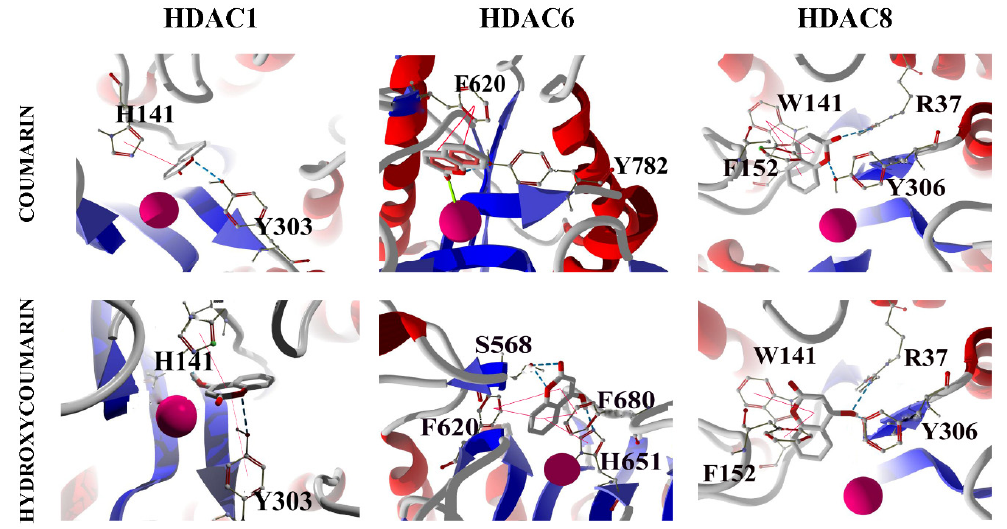
Figure 9. Potential interactions between the coumarin and 4-hydroxycoumarin and the residue in the active site of HDAC1, HDAC6 and HDAC8. The stacking interactions are show as a red line, hydrogen bond is blue dotted line and the coordination bond with Zinc is the green line.